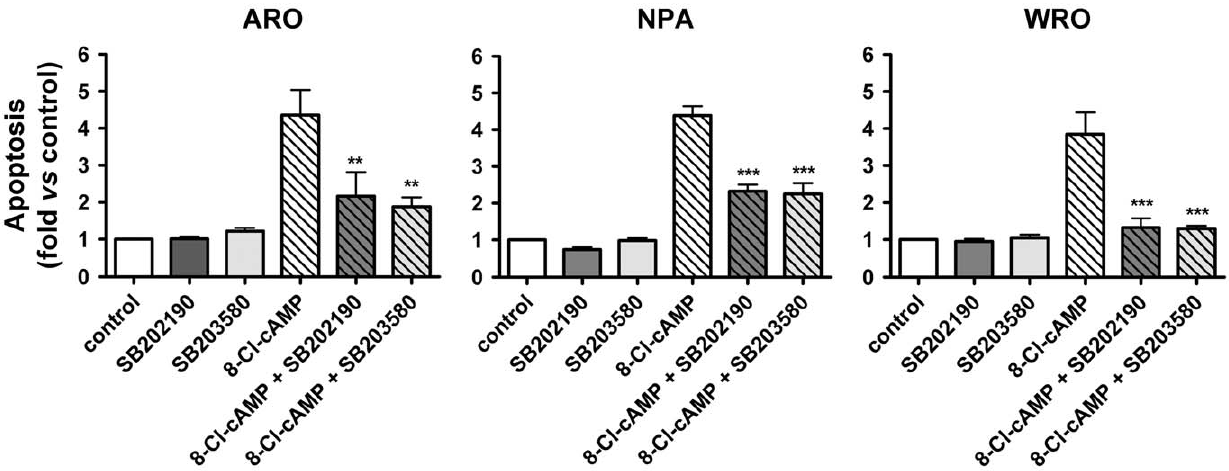
Figure 7. Effect of p38 MAPK inhibitors on the apoptosis induced by 8-Cl-cAMP. Cells were stimulated with 8-Cl-cAMP (100 m M) either in the presence or in the absence of p38 MAPK inhibitors (10 m M SB203580 or SB202190) for 72 h and apoptosis was evaluated by flow cytometry analysis after propidium iodide staining. Data are from at least three independent experiments. Data are expressed as the variation versus control cell culture. * P , 0.05 and ** P , 0.001 vs. cells treated with 8-Cl-cAMP